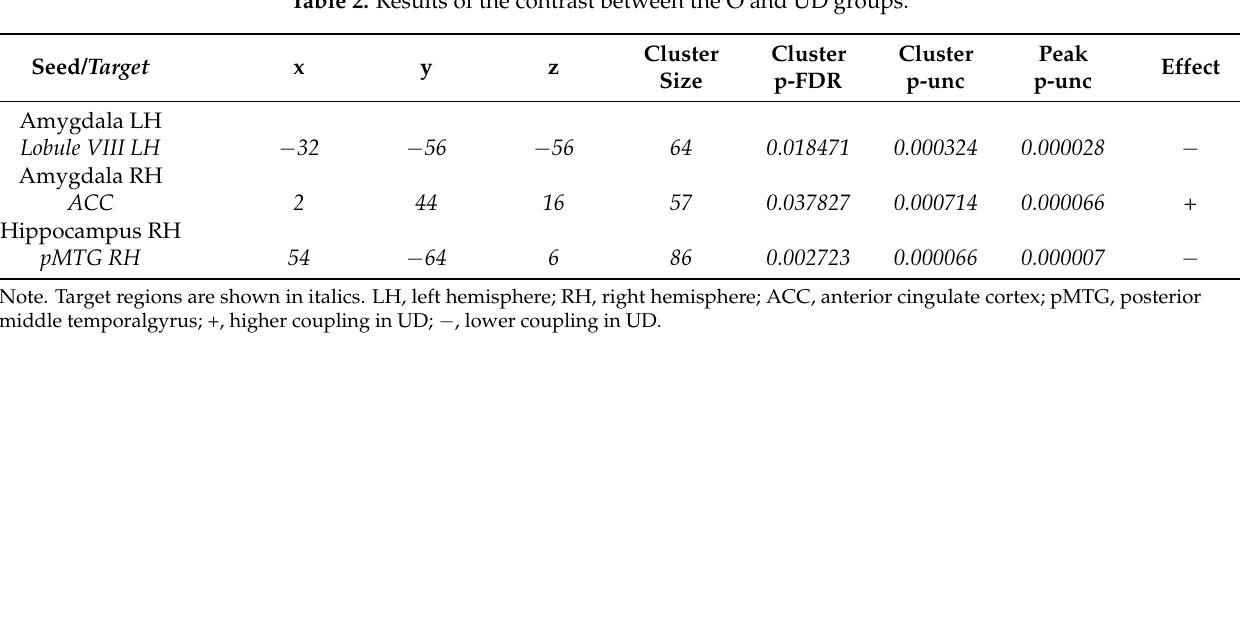
Table 2. Results of the contrast between the O and UD